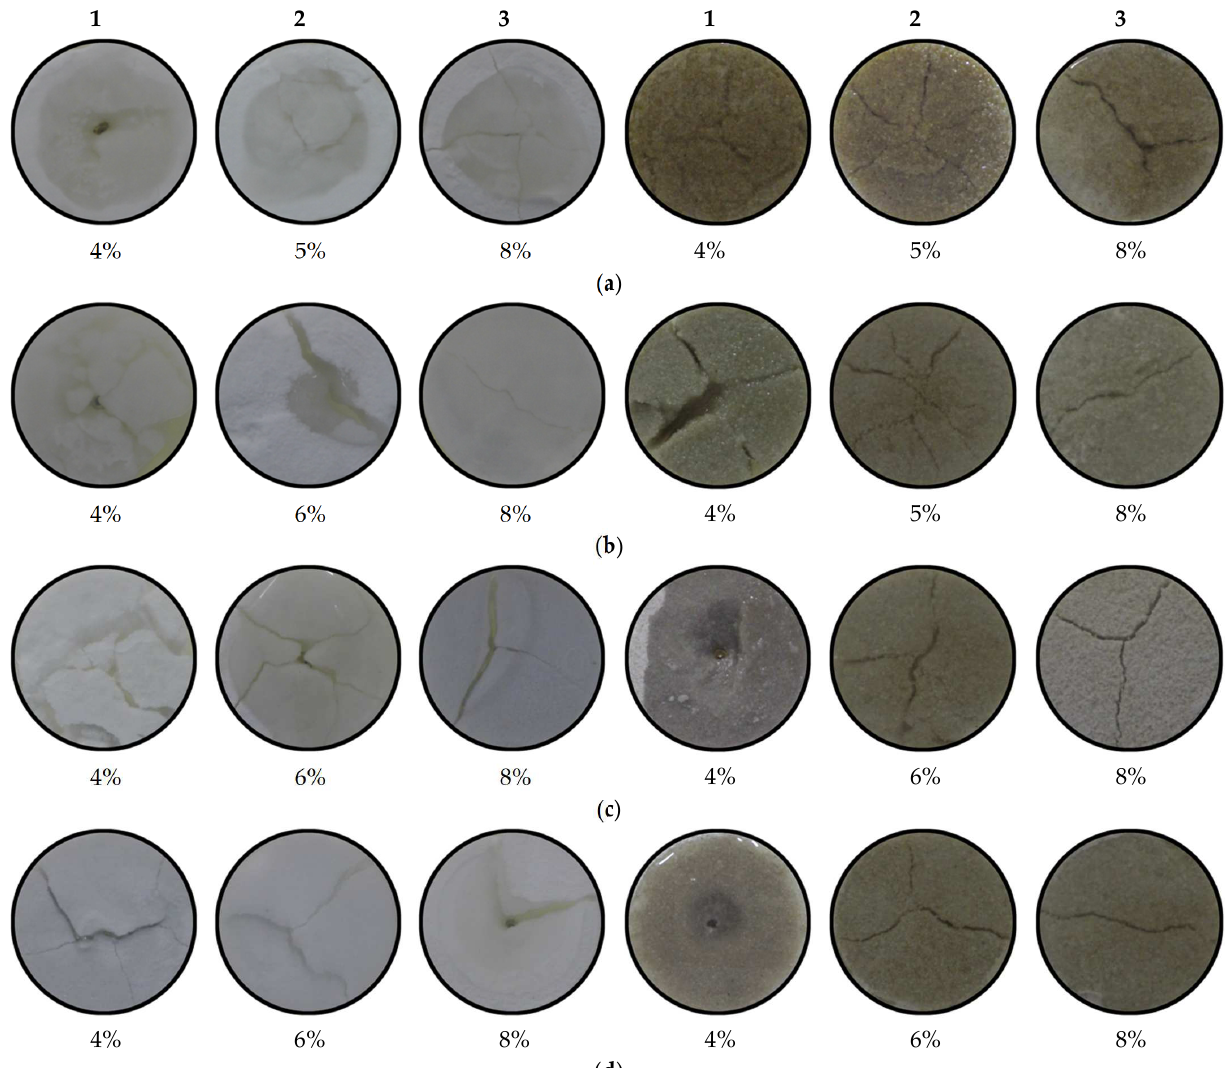
Figure 5. Example snapshots of the fractures immediately after the failure appeared during glycerine injection experiments at 30, 100, 200, and 400 mL/min in bio-cemented glass beads (first three on the left-hand side) and medium-grained bio-cemented sands (last three on the right-hand side) across various cementation levels: ( a ) 30 mL/min, ( b ) 100 mL/min, ( c ) 200 mL/min, ( d ) 400 mL/min.